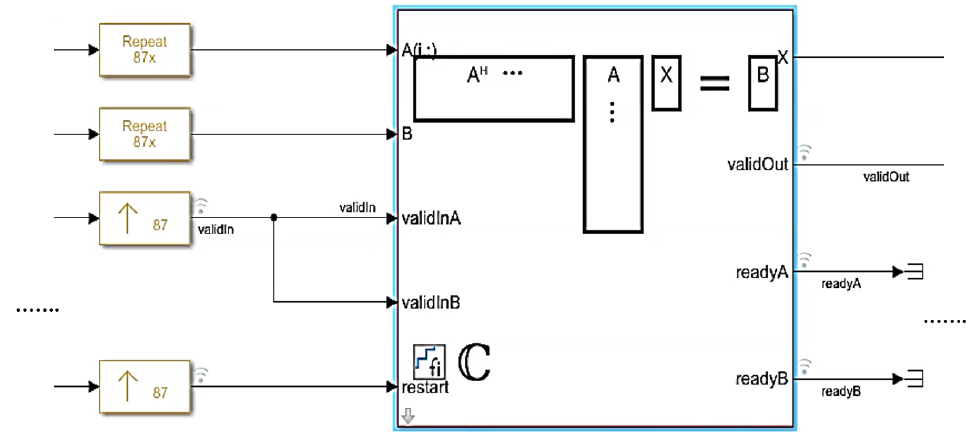
Figure 8. The quadrature programming solver for solving the QS-SVM problem in the HDL imple-